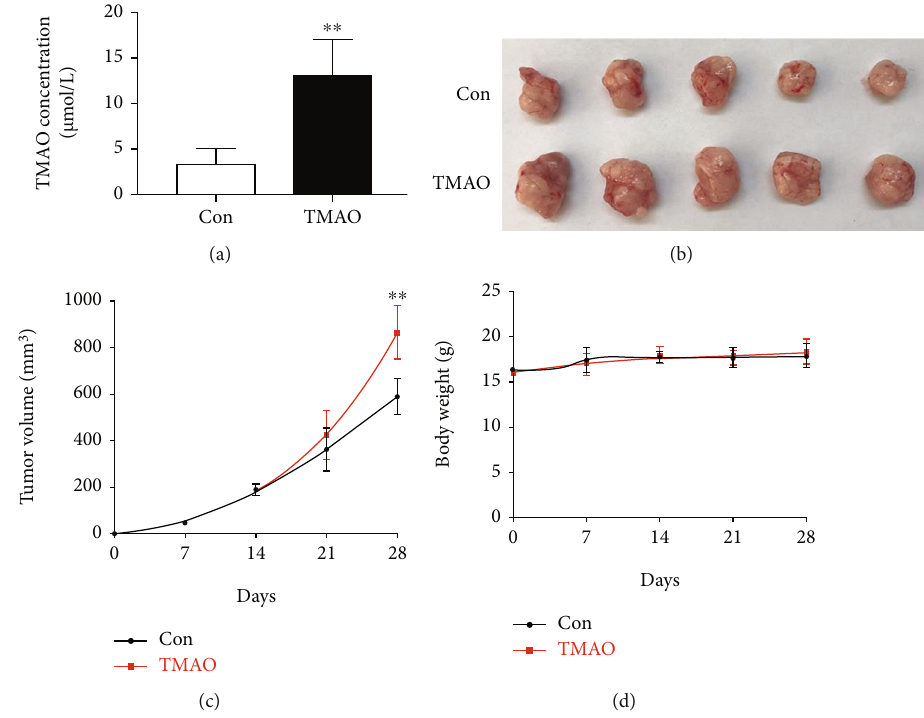
Figure 3: Tumor volumes and body weights in tumor-bearing mice after choline treatment. (a) Plasma levels of TMAO. (b) Representative photographs of exfoliated tumors from tumor-bearing animals. (c) Tumor volume curves and (d) body weight growth curves of mice over time in various groups. Con: control group; TMAO: 1.3% choline feeding. ∗∗ P < 0 : 01 versus Con group ( n = 5 ).